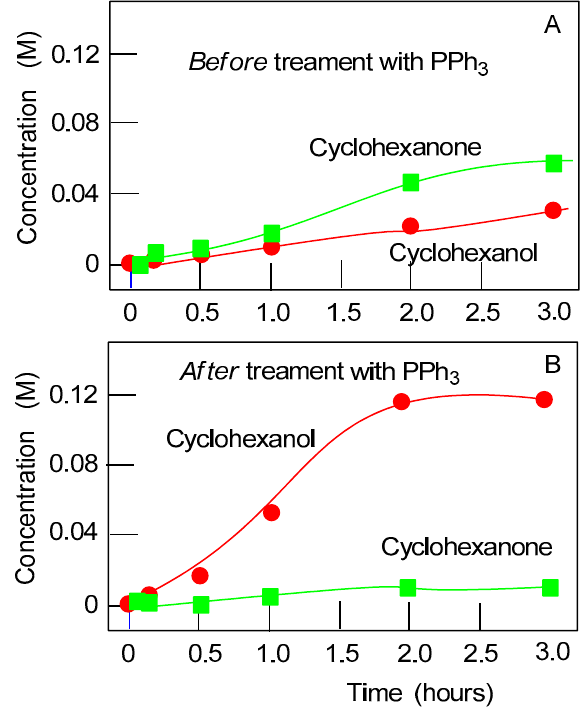
Figure 9. Oxidation of cyclohexane with hydrogen peroxide (50% aqueous) catalyzed by compound 9 in MeCN at 50 ◦ C (Graphs ( A , B )); total volume of the reaction solution was 5 mL. Concentrations of cyclohexanone and cyclohexanol were determined before (Graph A ) and after (Graphs B ) reduction of the aliquots with solid PPh 3 . Total yield of products 27% after 2 h, TON = 250 at 50 ◦ C and 30% after 1 h, TON = 280 at 60 ◦ C. adapted from [72], Copyright (2020) with permission of Elsevier.